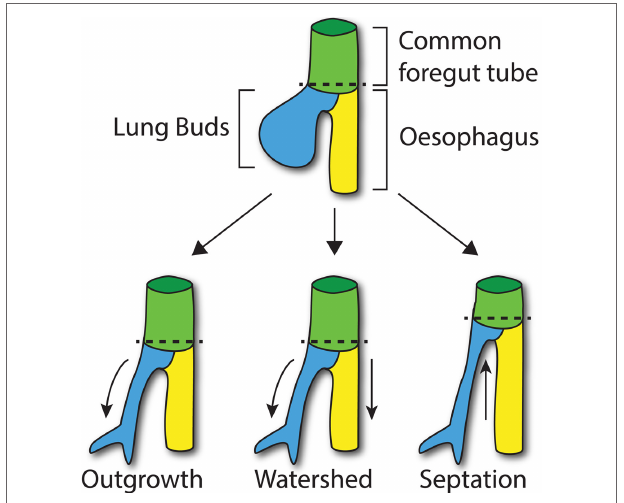
FiGURe 1 | Compartmentalization of the foregut . At E9.5 in the mouse, the lung buds start to arise from the common foregut tube (dashed line; top). According to the Outgrowth model (bottom left), the trachea extends from the foregut tube at the level where lung buds develop (curved arrow). The Watershed model suggests that both developing trachea and esophagus elongate (arrows) from the diverging point (dashed line; middle). According to the Septation model (bottom right), a septum is formed from lateral ridges of mesenchyme, which moves up along the longitudinal axis of the common foregut tube separating the trachea and esophagus